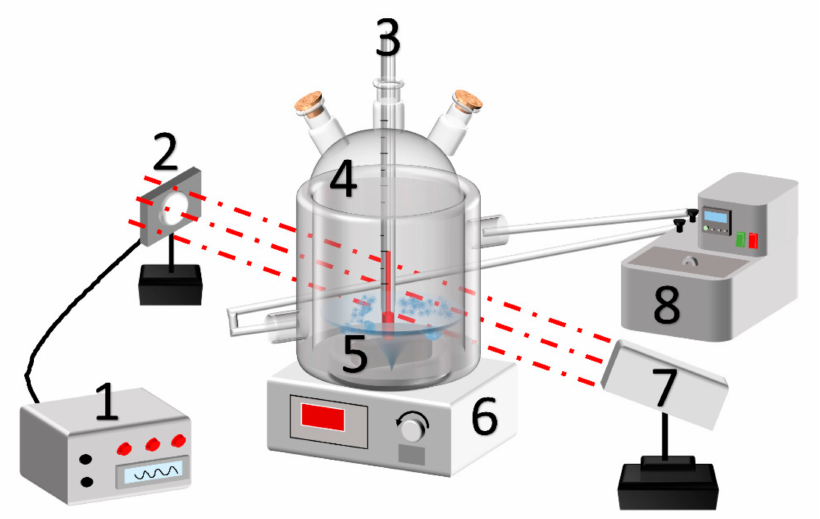
Figure 1. Schematic diagram of the induction period determination device (1—recorder; 2—laser receiver; 3—precision thermometer; 4—dissolver; 5—magnetic stirring rotor; 6—magnetic stirrer; 7—photoelectric transmitter; 8—super thermostat water